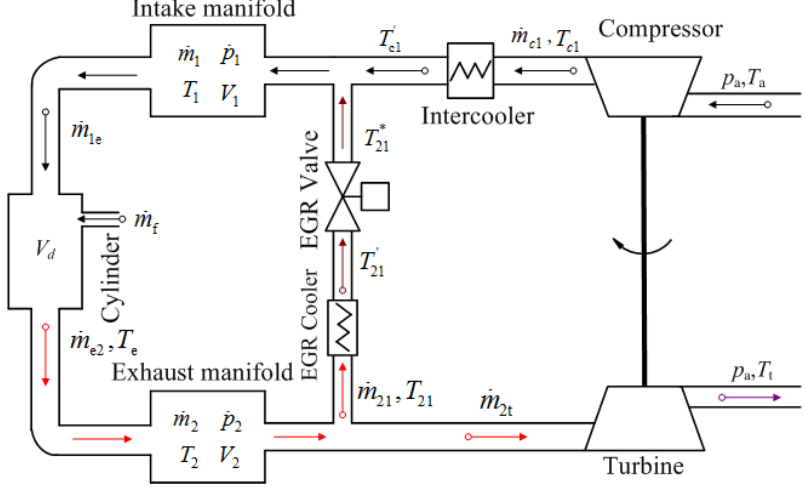
Figure 1. Block diagram of turbocharged diesel engine with HP EGR